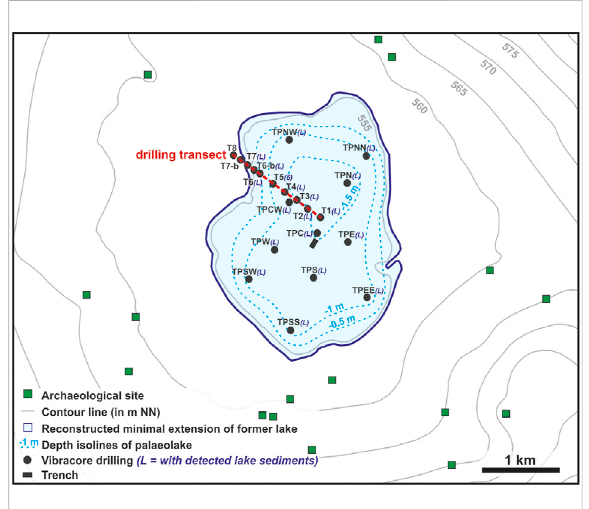
FIGURE 3 The lowest part of the Shiraki Plain with Late Bronze/Early Iron Age archaeological sites (Varazashvili and Pitskhelauri, 2011), core drillings, the studied trench and the maximal extension of the endorheic palaeolake based on the results of the occurrence of lake sediments that was extrapolated to the lowest part of the Shiraki Plain. However, given that lake sediments must have been deposited below a water column of unknown depth, the real maximal extension of the lake must have been somewhat larger than shown